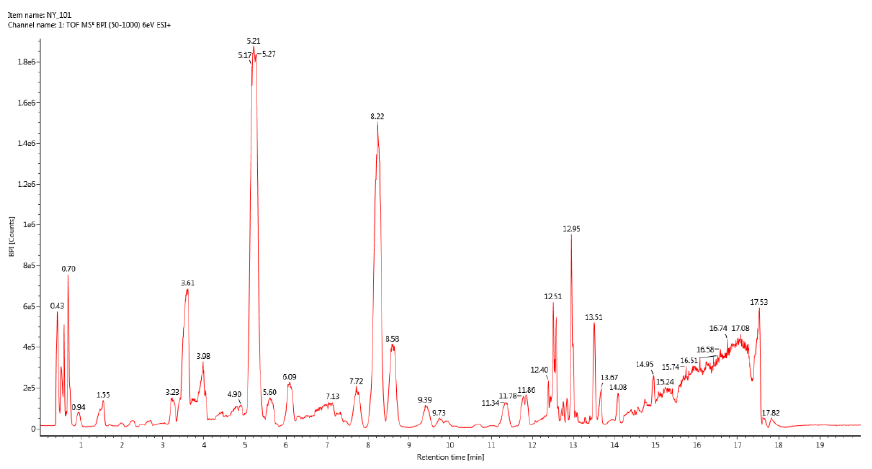
Figure 1. BPI total ion chromatogram of group 1.